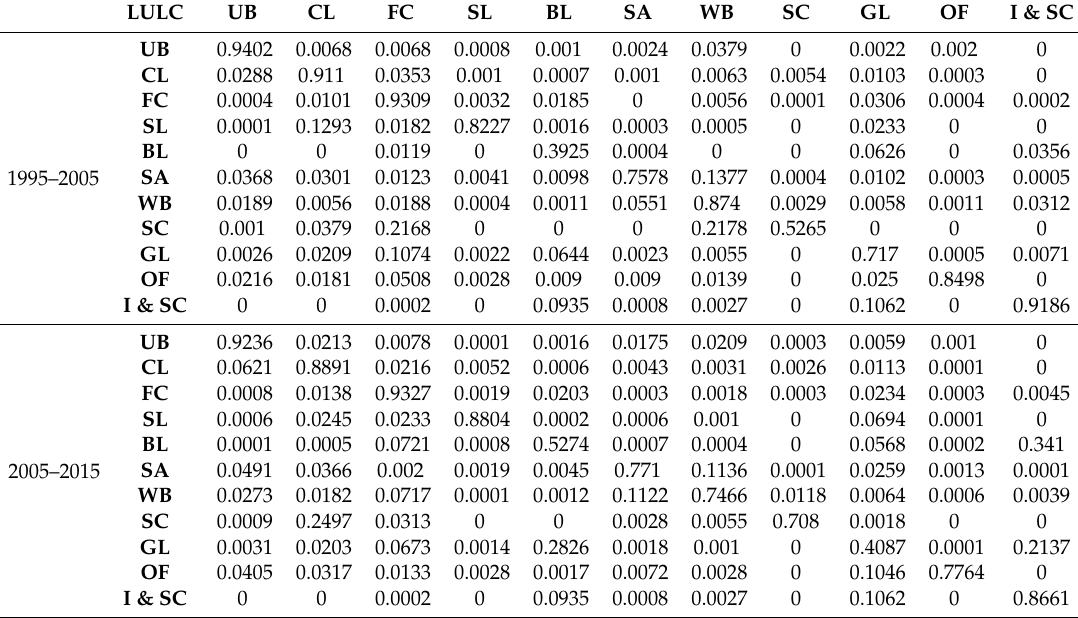
Table 5. Transition probability matrix of LULC classes for the periods 1995–2005 and 2005–2015.